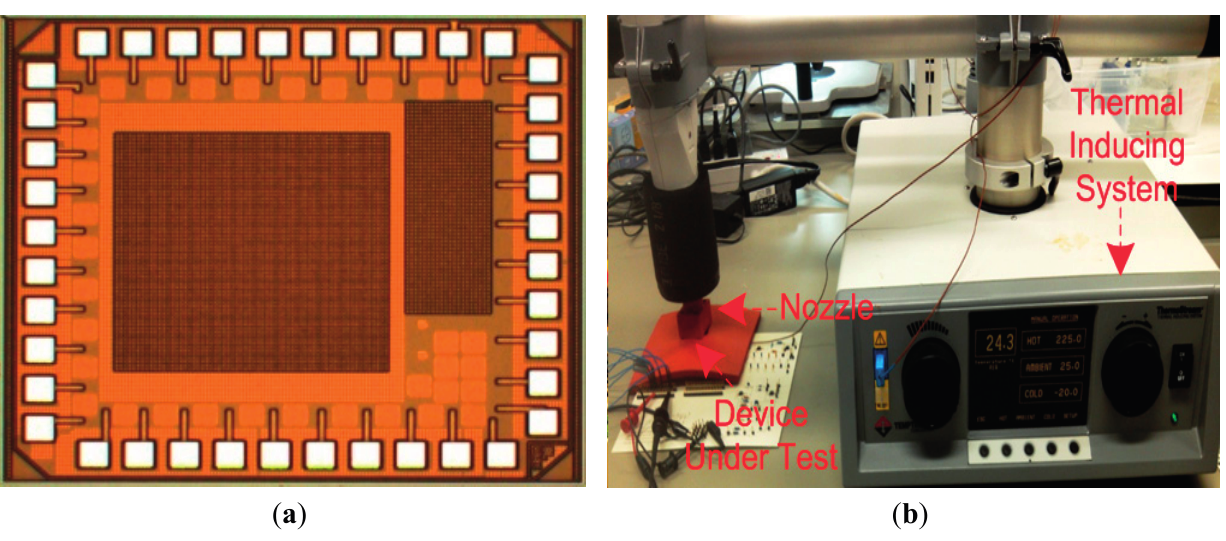
Figure 3. ( a ) Chip microphotograph measuring 1950 mm × 1850 mm, where the effective area of the CMOS sensor interface circuit is 460 μ m × 290 μ m; ( b ) Experimental setup of Thermostream TP04100A thermal inducing system.